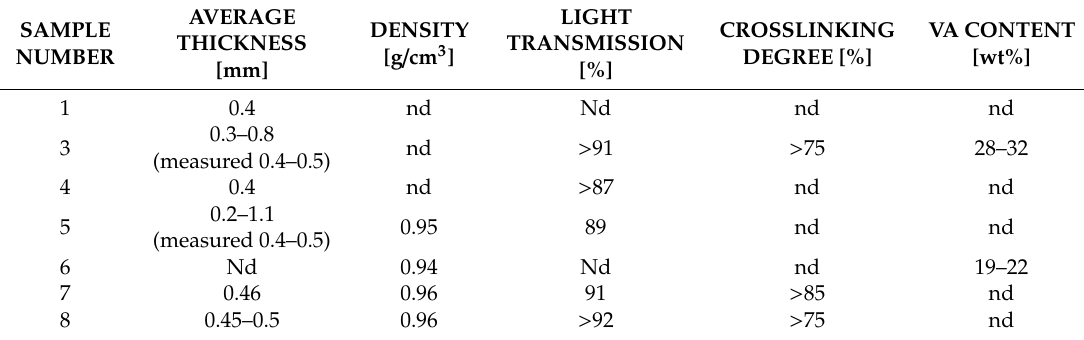
Table 2. Physical, chemical, and optical properties of EVA samples used in the experiment.